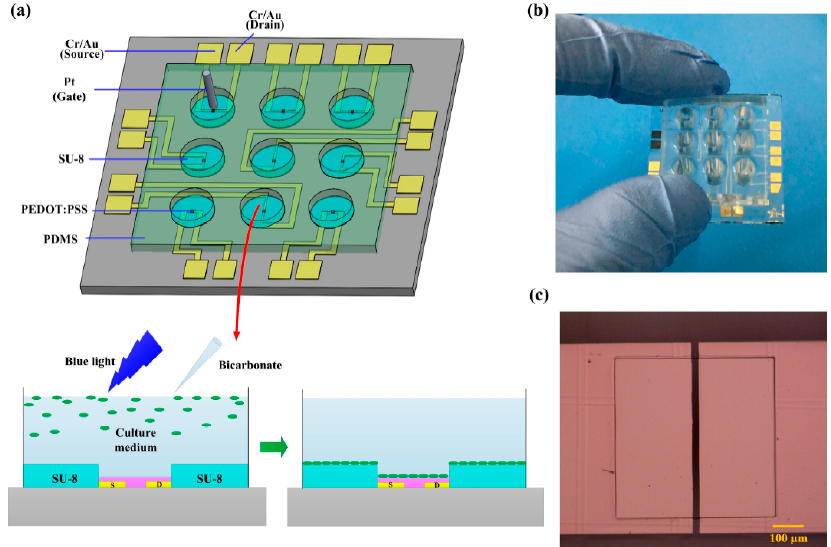
Figure 16. ( a ) Scheme of an OECT array. The electrical characteristics of the OECTs depend on the